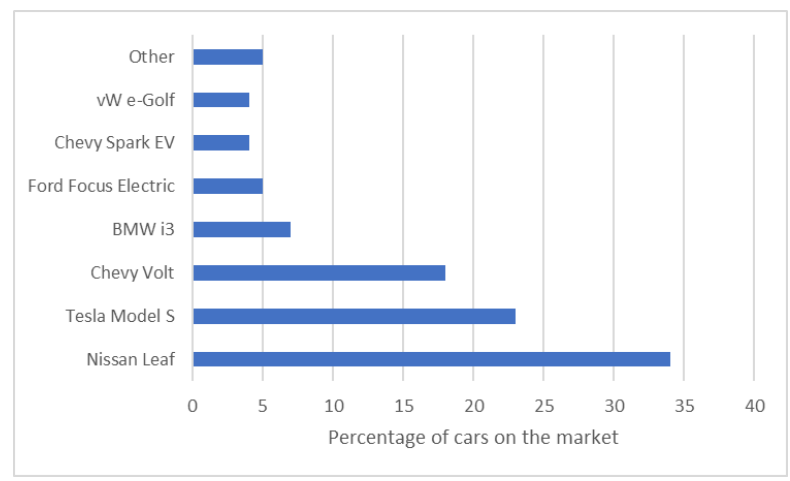
Figure 5. The global market share of the most popular EVs according to the survey [6].